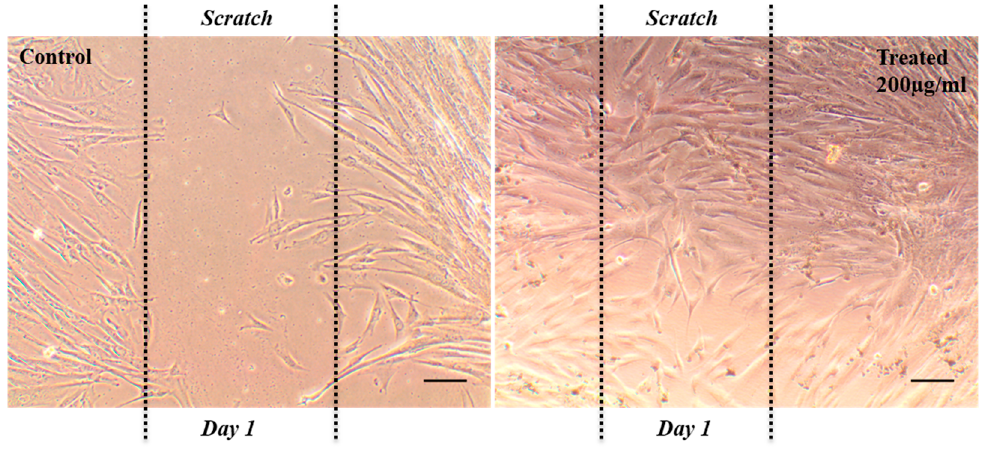
Figure 4. Phase-contrast images of migration assay showing the enhanced cell migration in treated cells (200 µg/mL) than control in scratch area (scale bar: 50 µm). cells (200 µ g/mL) than control in scratch area (scale bar: 50 µ